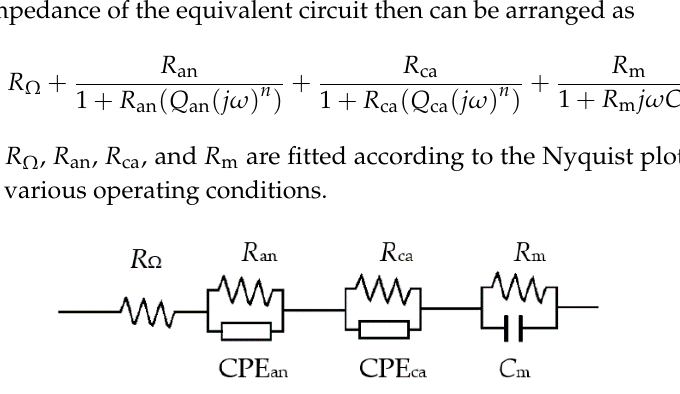
Figure 3. Equivalent circuit used to fit the experimental data. ( R Ω : internal resistance; R an : anode charge transfer resistance; R ca : cathode charge transfer resistance; R m : mass transfer resistance; C m : mass transfer effect; CPE an : constant phase element of the anode; CPE ca : constant phase element of the cathode).